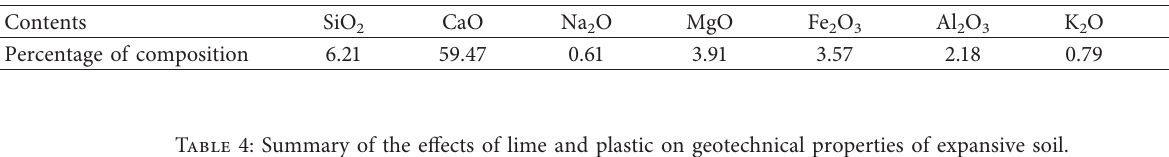
Table 3: Chemical composition of the hydrated lime used in this study [4].